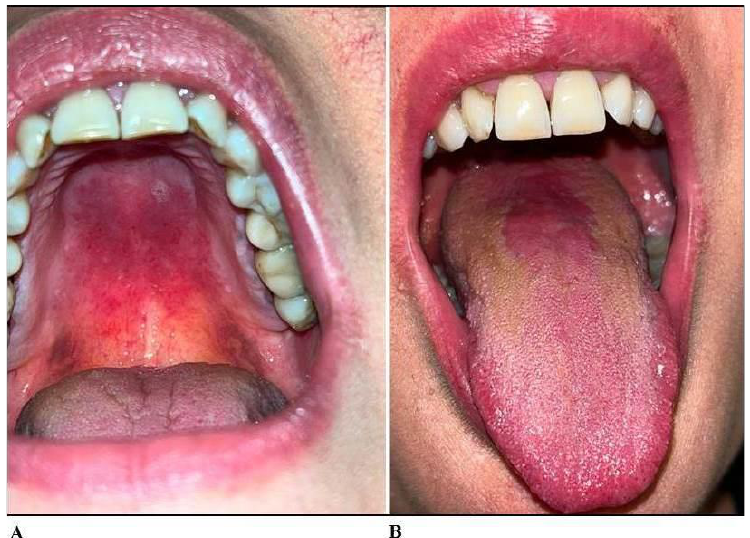
Figure 1. Oral Candidiasis clinical features. ( A ) Erythema and erosive areas at the palate. ( B ) Erythematous-atrophic glossitis.